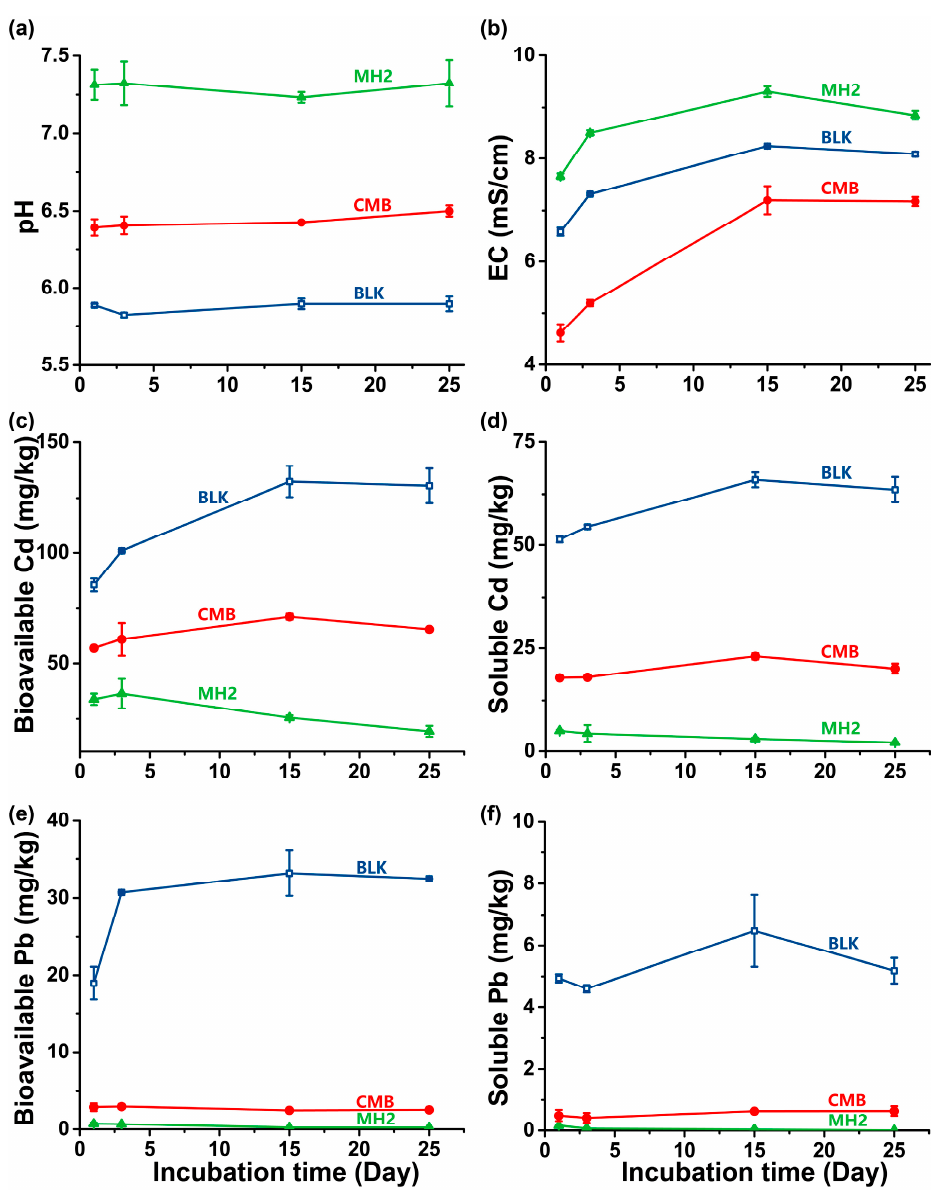
Figure 5. The pH ( a ) and EC ( b ) variations in the soil amended by CMB or MH2. Bioavailable con- centrations of Cd ( c ), Pb ( e ) and water-extractable Cd ( d ), Pb ( f ) in the soil during CMB or MH2